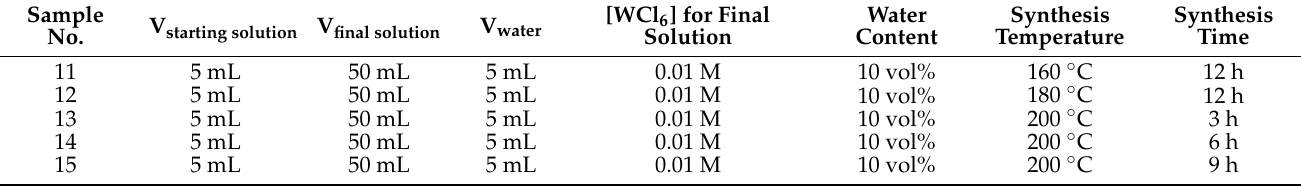
Table 2. Details of the solvothermal synthesis: list of applied synthesis temperatures and times. For convenience, we use [WCl 6 ] to denote precursor